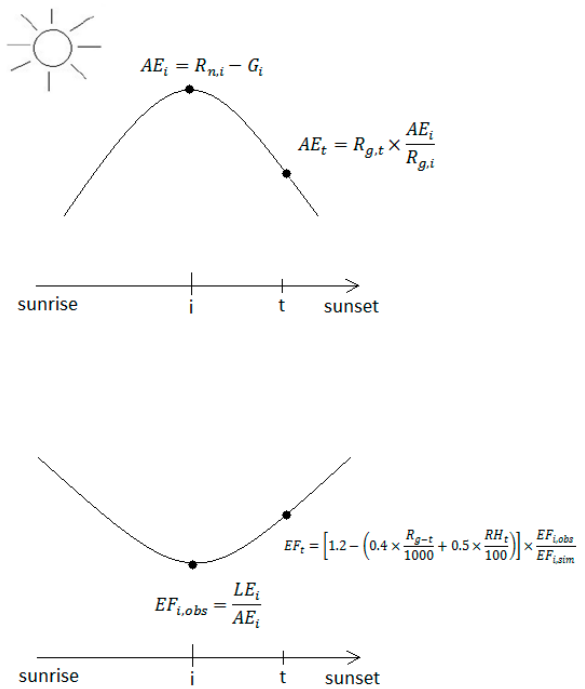
Figure 2. Extrapolation method to reconstruct daily ET from instantaneous measurements the days with data acquisitions.